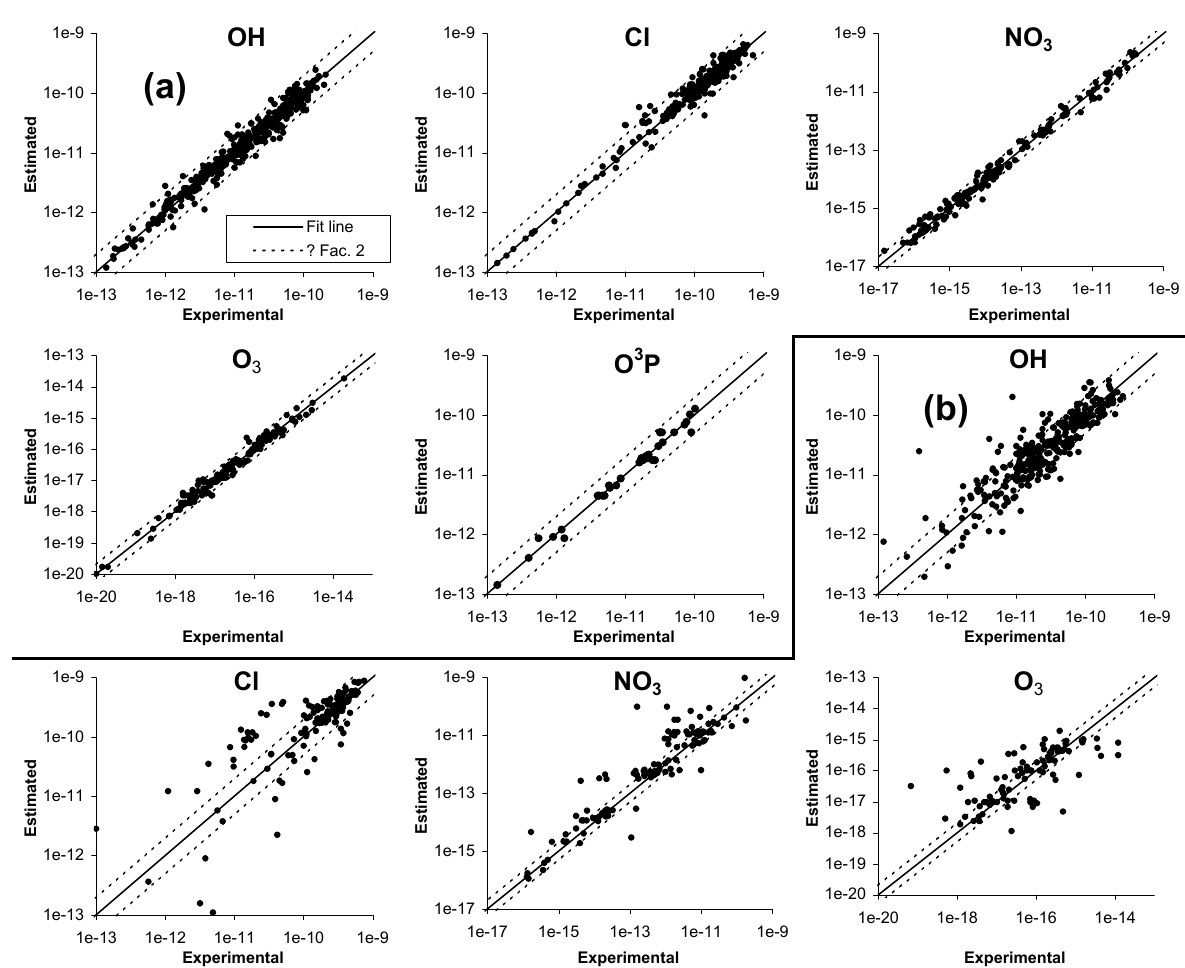
Figure 1. Plots of estimated vs. experimental 298 K rate constants for ( a ) compounds used for parameter derivations, and ( b ) compounds used for evaluation only.